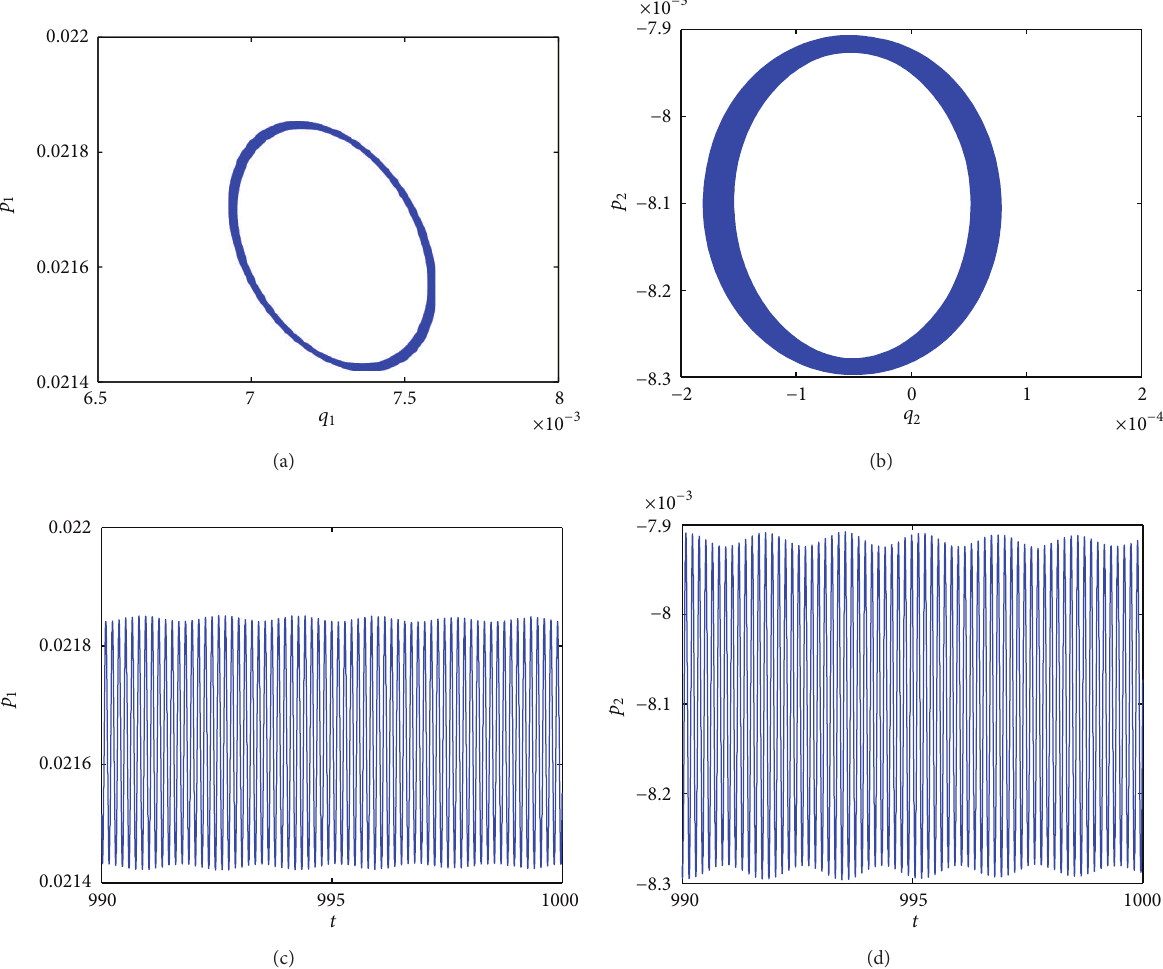
Figure 10: Phase portraits (a, b) and time histories (c, d) for 𝜎 2 = 75.2799 , 𝜇 = 0.05 , V 1 = 10 , 𝛼 = 0 , and 𝜎 1 = 92.39